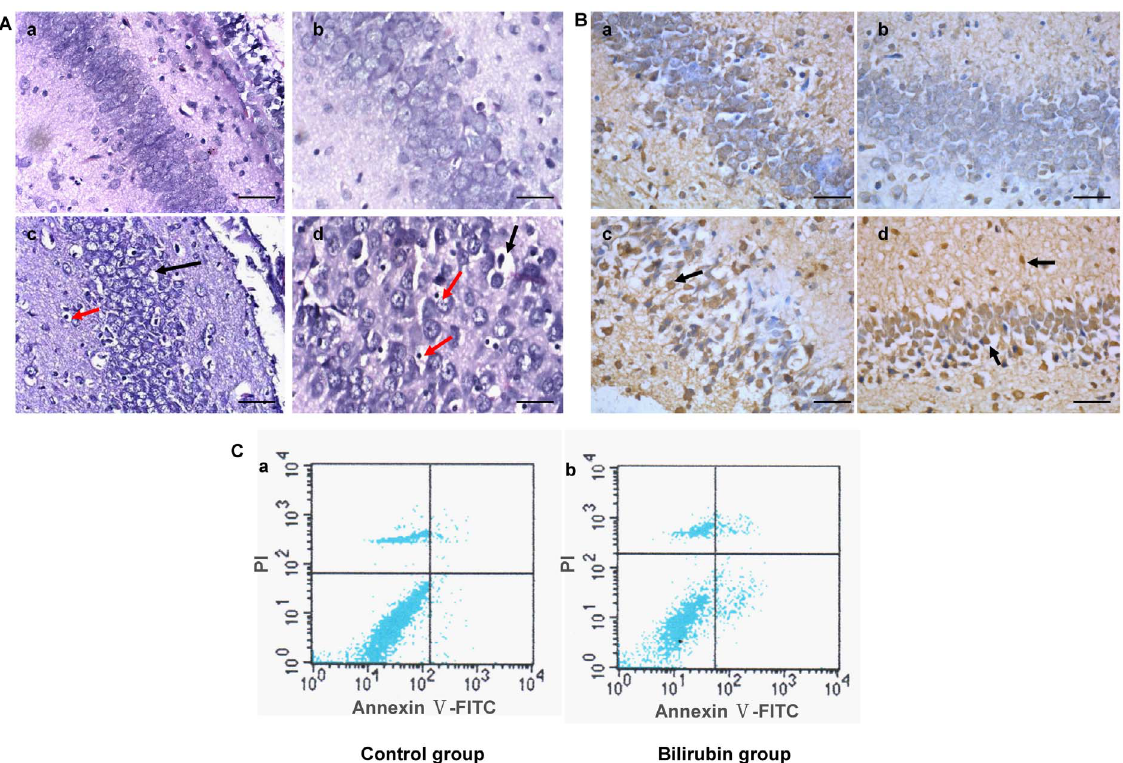
Figure 3. Histology and flow cytometry (FCM) at 24 hours after bilirubin injection. (A) H&E staining under light microscopy. Hippocampal nerve cells in the CA-3 region were morphologically normal in the control group (a, b). Cellular edema and swelling (c, d) (black arrow), and cell necrosis, including cytoplasmic condensation, endolysis, nuclear pyknosis, karyorrhexis and karyolysis (c, d) (red arrow), were observed in the bilirubin group (n=8 in each group). (a), (c): 200 6 , scale bars=200 m m; (b), (d): 400 6 , scale bars=100 m m. (B) TUNEL assay under light microscopy. Few apoptotic cells in the CA-3 (a) and CA-1 (b) regions were observed in the controls. Apoptotic cells were observed in the CA-3 (c) and CA-1 (d) (black arrow) regions of the hippocampus in the bilirubin-treated rats. (n=8 in each group). Scale bars=100 m m. (C) Annexin V-FITC/PI (FCM) was used to determine the apoptotic (right lower quadrant) and necrotic (right upper quadrant) rates of the two groups. The apoptotic and necrotic rates of the controls were 1.33 6 0.36% and 1.26 6 0.89%, respectively (a). In the bilirubin group, the apoptotic and necrotic rates were 9.41 6 0.88% and 4.74 6 0.60%, respectively (b). There were significant differences in both the apoptotic and necrotic rates between the two groups ( P , 0.01). (n=8 in each